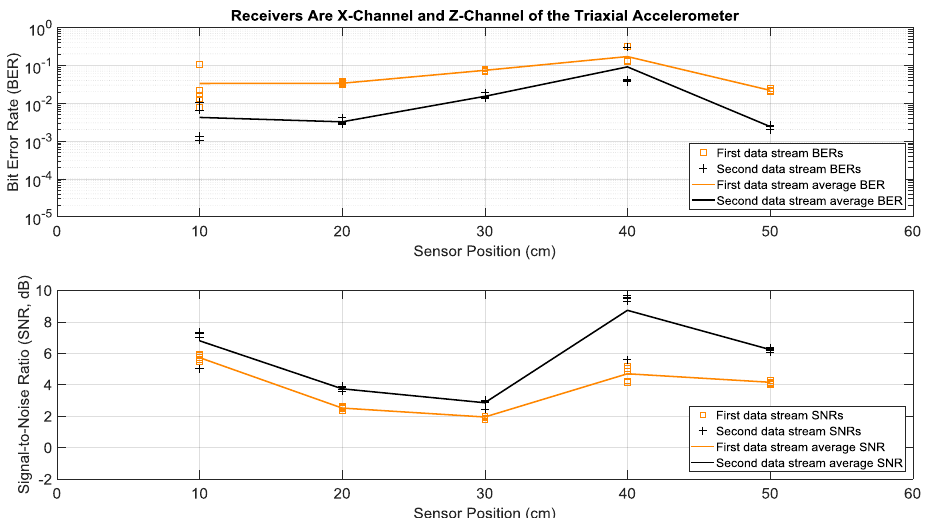
Figure 10. BERs ( top ) and SNRs ( bottom ) at different receiver positions, with two actuators transmitting two data streams simultaneously. The receivers were the x -channel and z -channel of a triaxial accelerometer. The piecewise linear graphs represent the average BERs and SNRs for each of the two data streams versus the receiver position.